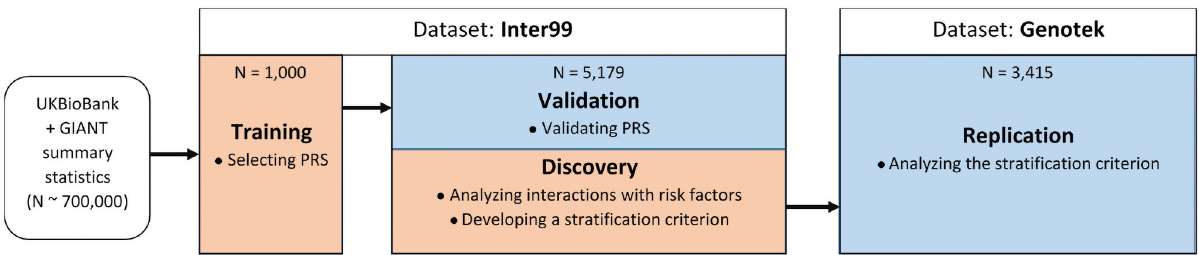
Fig 1. The overall workflow of the analysis. The flow of the data and the steps of the analysis. The subsets of data are named “Training”, “Validation/ Discovery”, and “Replication”, according to the naming in the text. Orange color highlights steps of analysis where models were trained, blue color highlights steps of analysis where models were validated. The N = 5,179 subset of Inter99 was used both for the validation of the BMI PRS and for the discovery of the interactions with risk